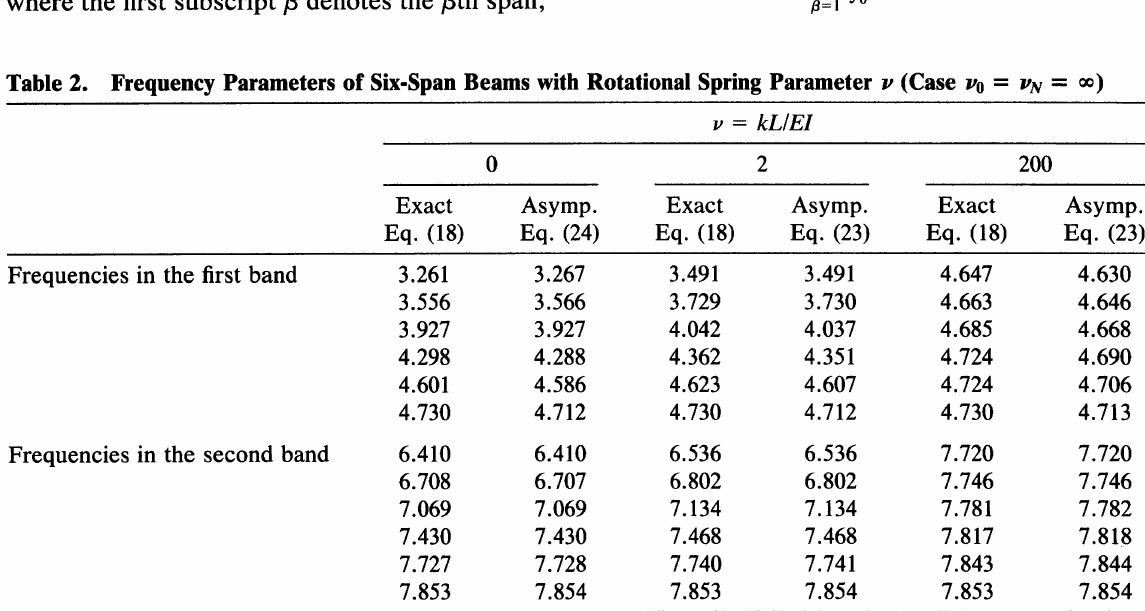
Table 2. Frequency Parameters of Six-Span Beams with Rotational Spring Parameter v (Case Vo